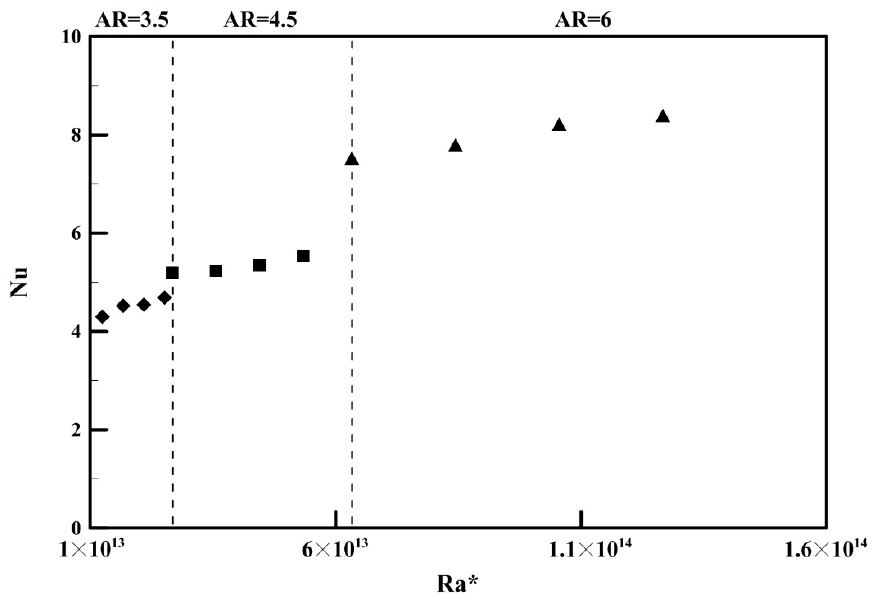
Figure 6. Relationship between the average Nusselt number ( Nu ) and the modified Rayleigh number ( Ra *) of the heating section.